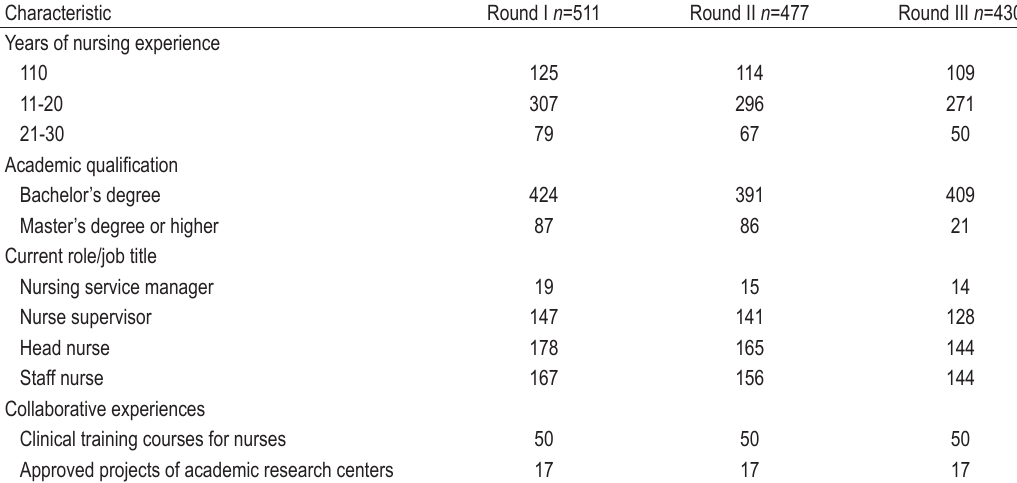
TABLE 1. The demographic profile of the participants from Rounds I, II, and III